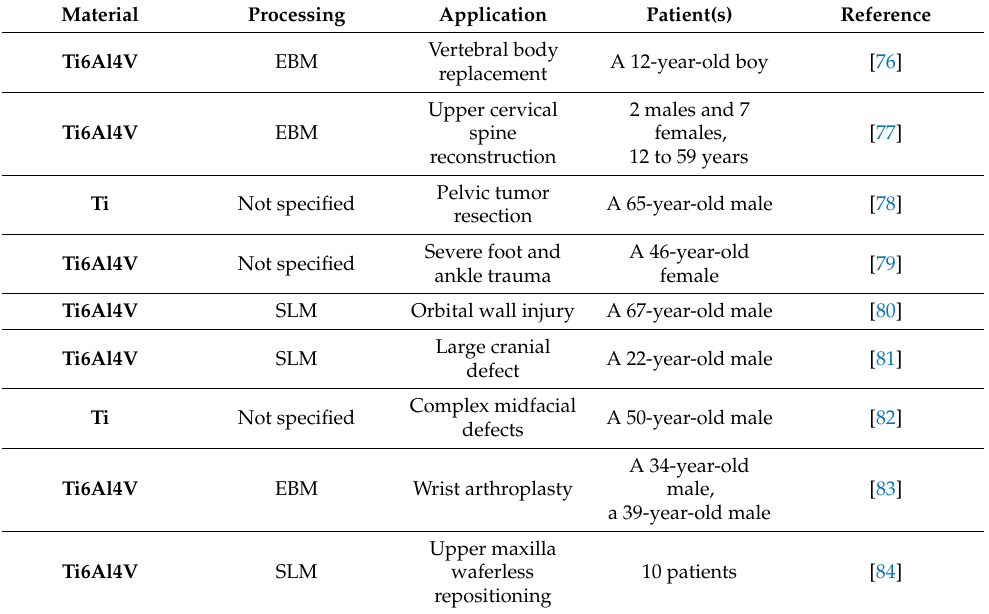
Table 4. Some examples of the clinical application of patient-specific 3D-printed metal materials in